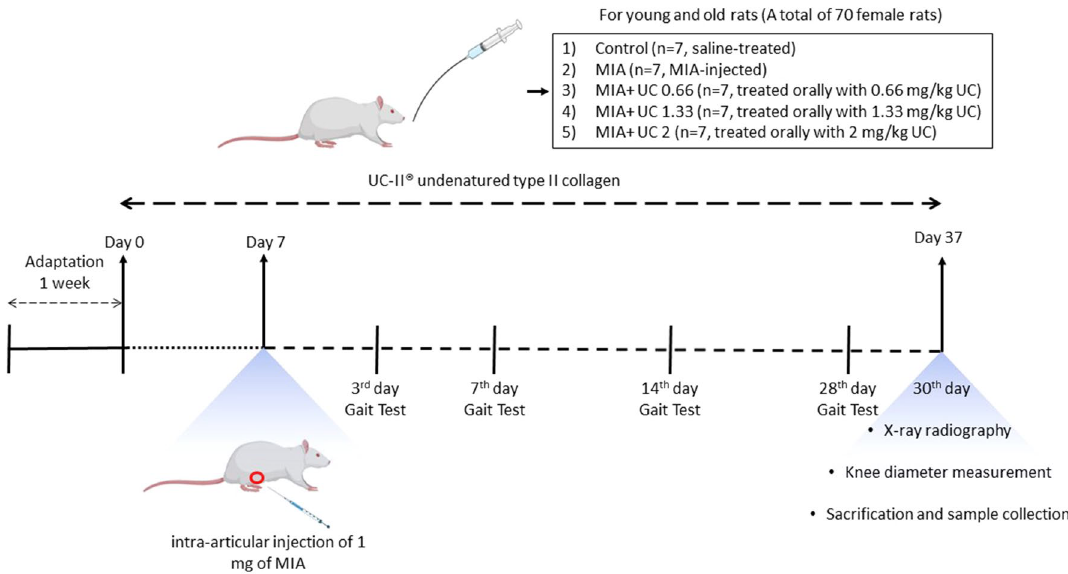
Figure 1. The experimental design of the study. MIA, monosodium iodoacetate; UC, undenatured